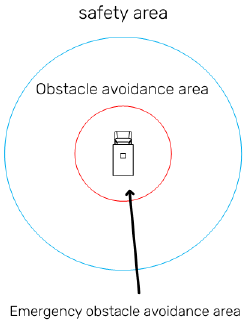
Figure 3. Obstacle avoidance